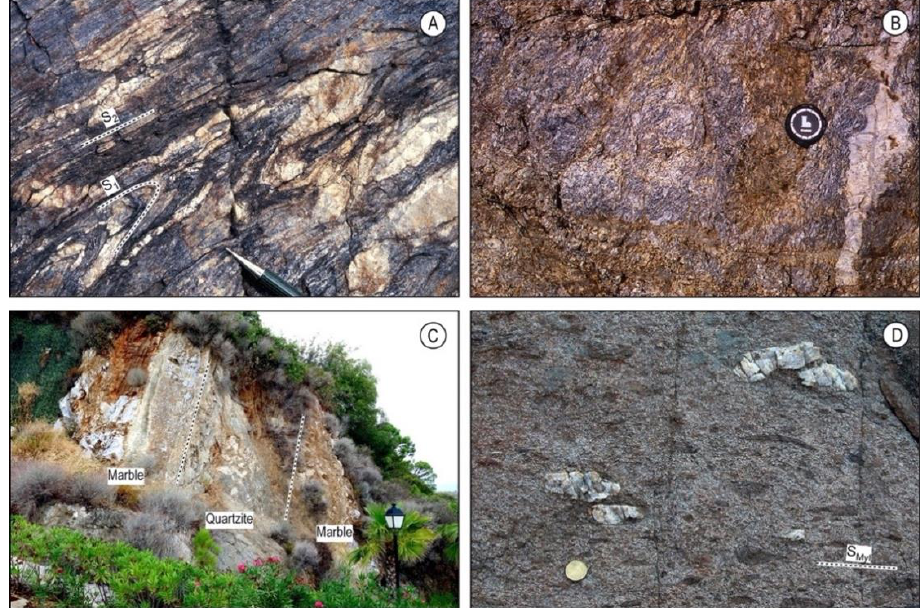
Figure 2. Field images of studied sample outcrops: ( A ) schists and quartzites of the metapelitic sequence (tb-2009-7), ( B ) Istan migmatites (tb-07-845), ( C ) interlayered quartzite within coarse-grained marbles (tb-18-06) and ( D ) Hoyo del Bote mylonitic migmatite (Gu-35-2) with elongated white quartz nodules and metapelitic restites (dark grey) that define the mylonitic foliation (S Myl ).